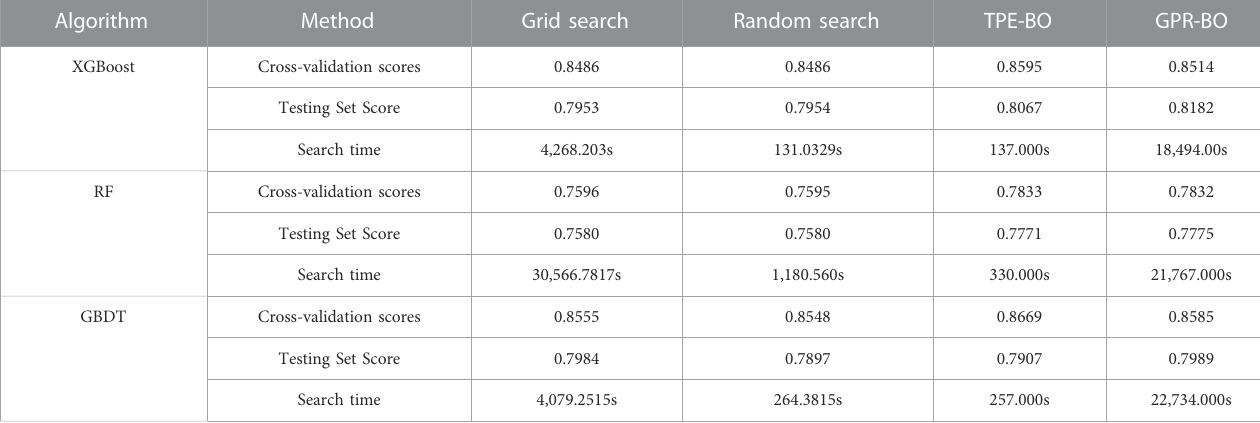
TABLE 3 Performance comparison of prediction models under different hyperparameter optimization methods.